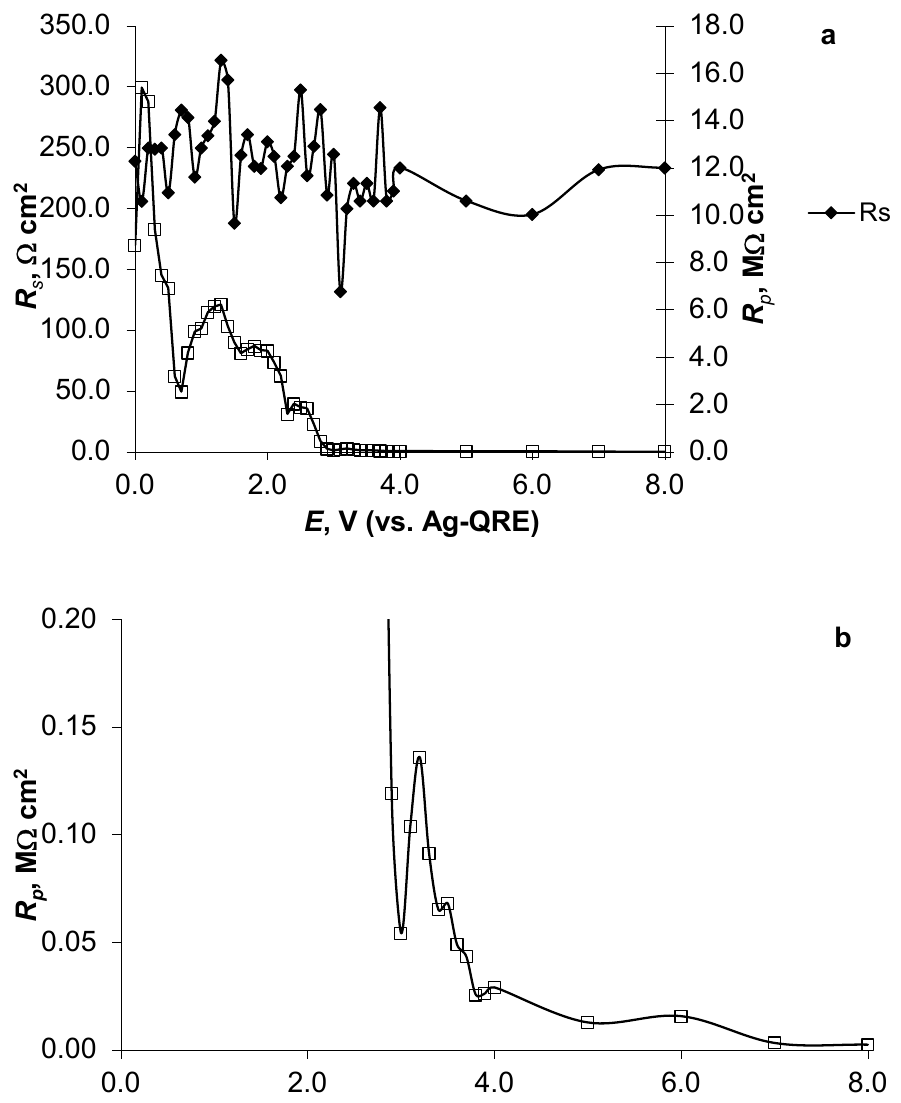
Figure 10. The series-resistivity ( R s ) ( a ) and parallel-resistivity ( R p ) ( b ) relationships vs. Al-electrode potential ( E ) applied.